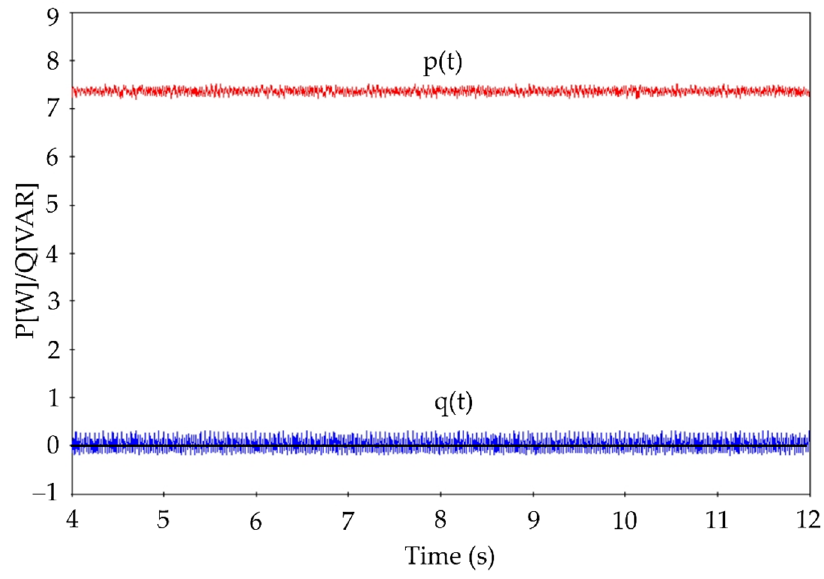
Figure 10. PQ control result for output power control simulation case.